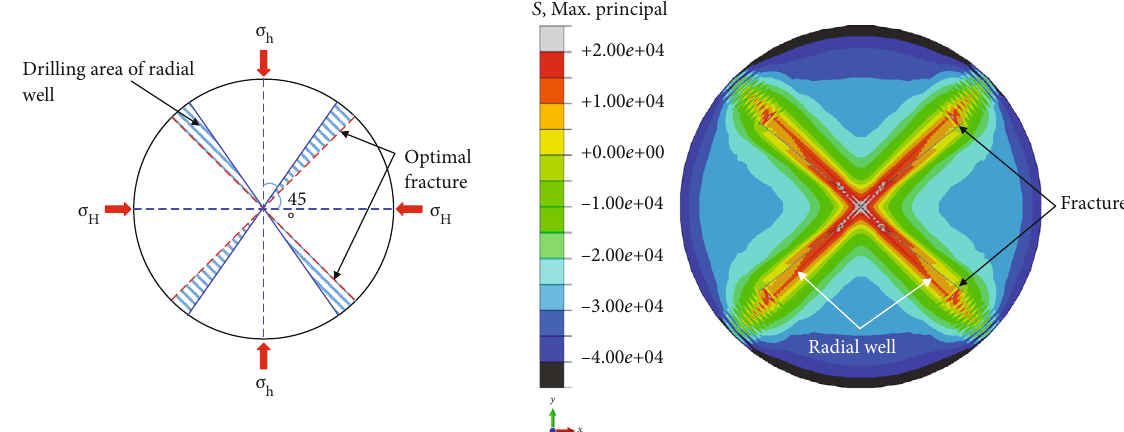
Figure 18: Optimization scheme of radial perforation.